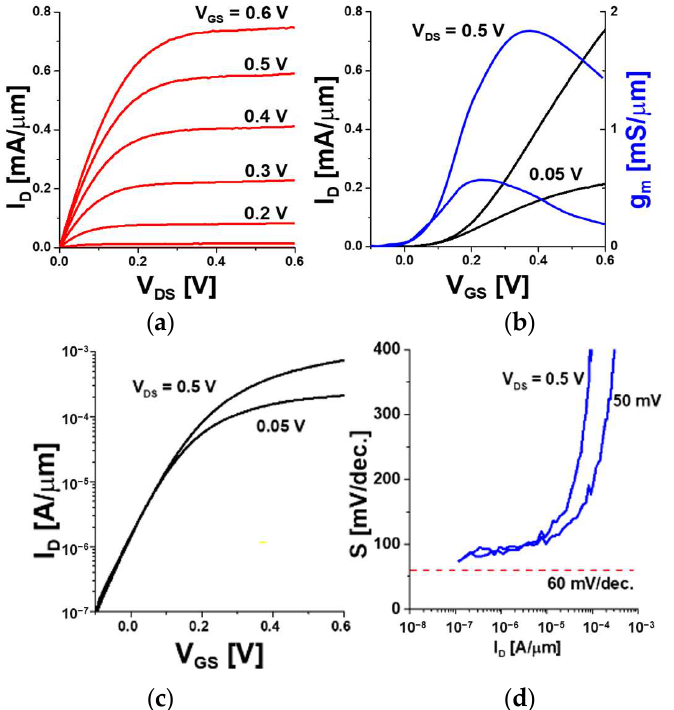
Figure 5. The measured DC behavior of the L g = 50 nm GAA In 0.53 Ga 0.47 As NS MOSFET: ( a ) output characteristics, ( b ) transfer/transconductance characteristics, ( c ) subthreshold characteristics and ( d ) subthreshold-swing ( S ) against I D .